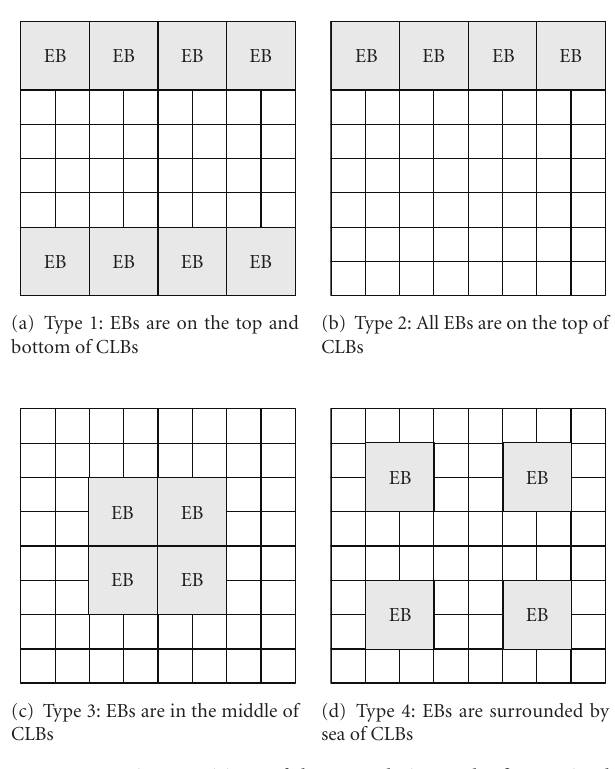
Figure 4: Various positions of the EBs relative to the fine-grained